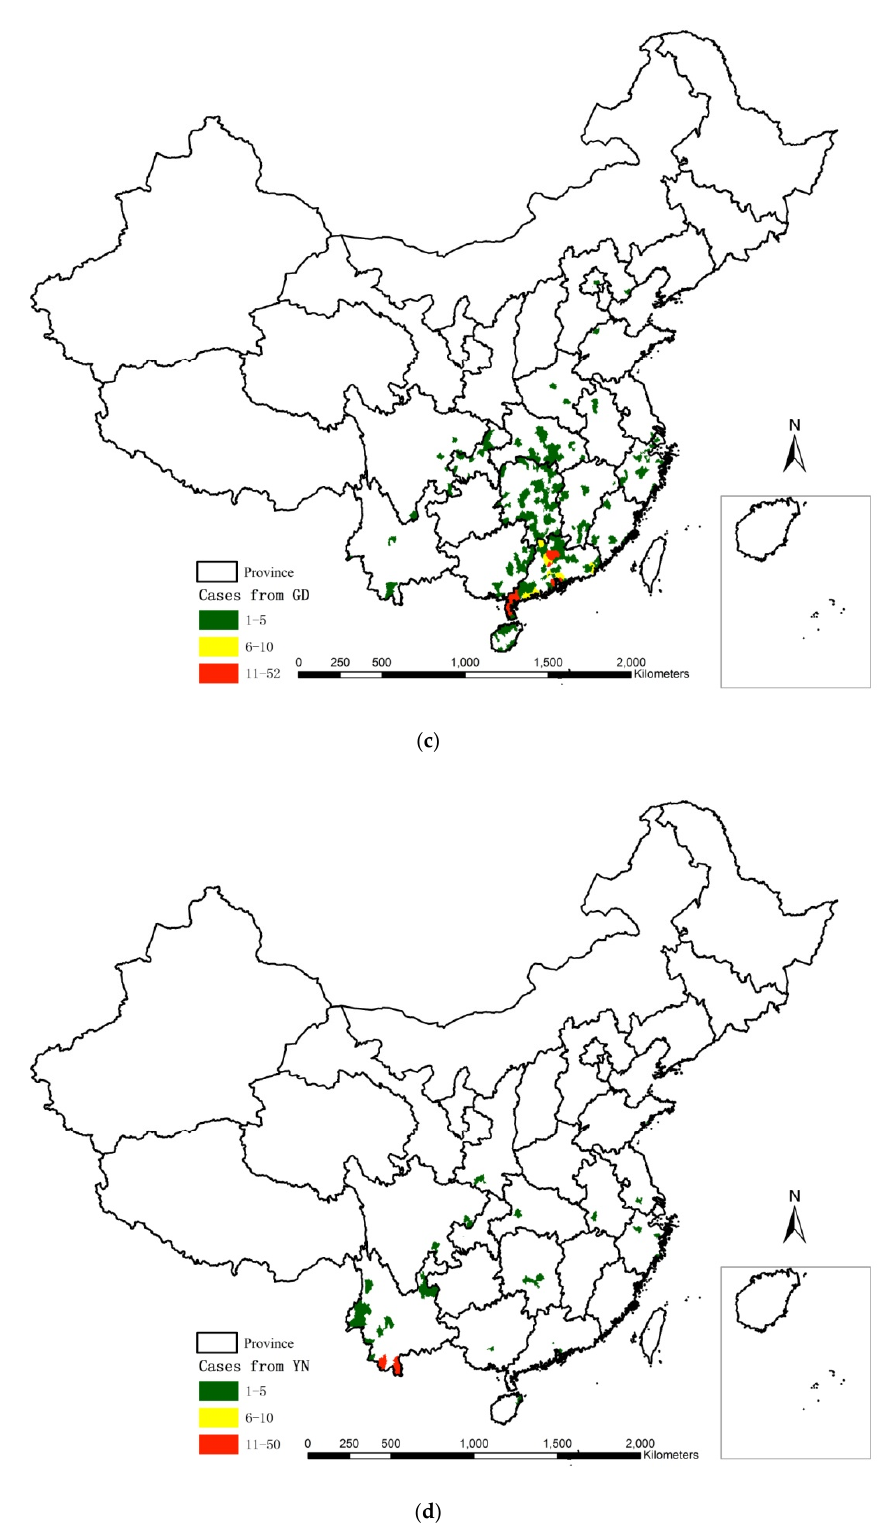
Figure 3. Spatial mapping of domestic imported dengue cases. ( a ) Spatial distribution of exported cases. ( b ) Spatial distribution of imported cases. ( c ) Cases from GD. ( d ) Cases from YN. (Note: YN: Yunnan; GD: Guangdong; GX: Guangxi; HN: Hainan; FJ: Fujian; SC: Sichuan; CQ: Chongqing; HuN: Hunan; HuB: Hubei; JX: Jiangxi; ZJ: Zhejiang; AH: Aihui; JS: Jiangsu; SH: Shanghai; HeN: Henan; HB: Hebei; SD: Shandong; SX: Shanxi; BJ: Beijing; HLJ: Heilongjiang).